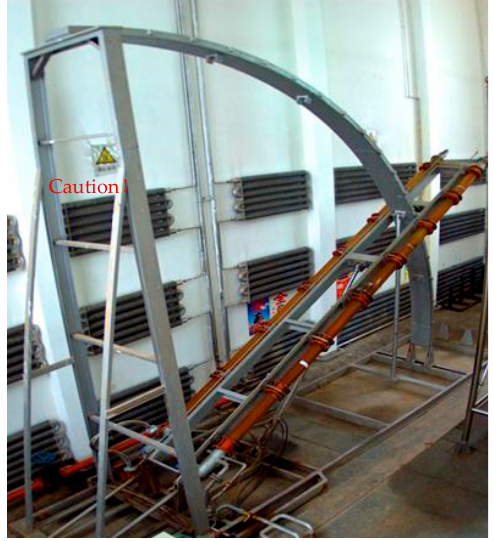
Figure 4. Photo of horizontal simulation well of Oil-water two-phase flow.